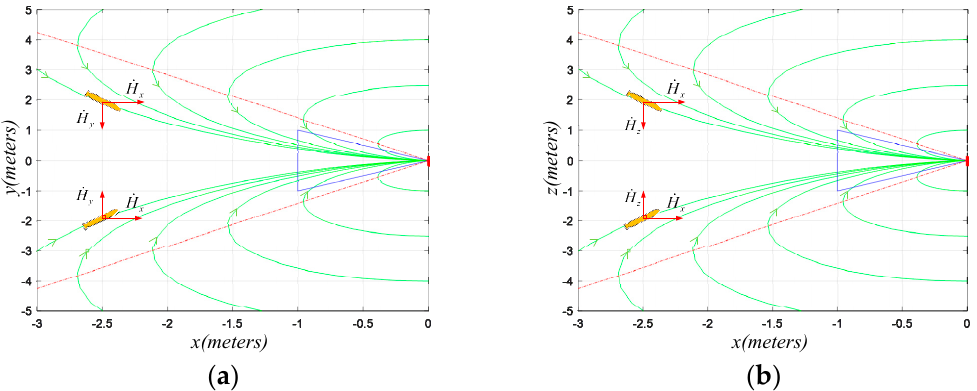
Figure 3. The distribution of the magnetic field vector of a point in front of the transmitting coil where the x-coordinate is negative; ( a ) is the plane xoy , and ( b ) is the plane xoz . Table 1. The relationship between four solutions and the phase of